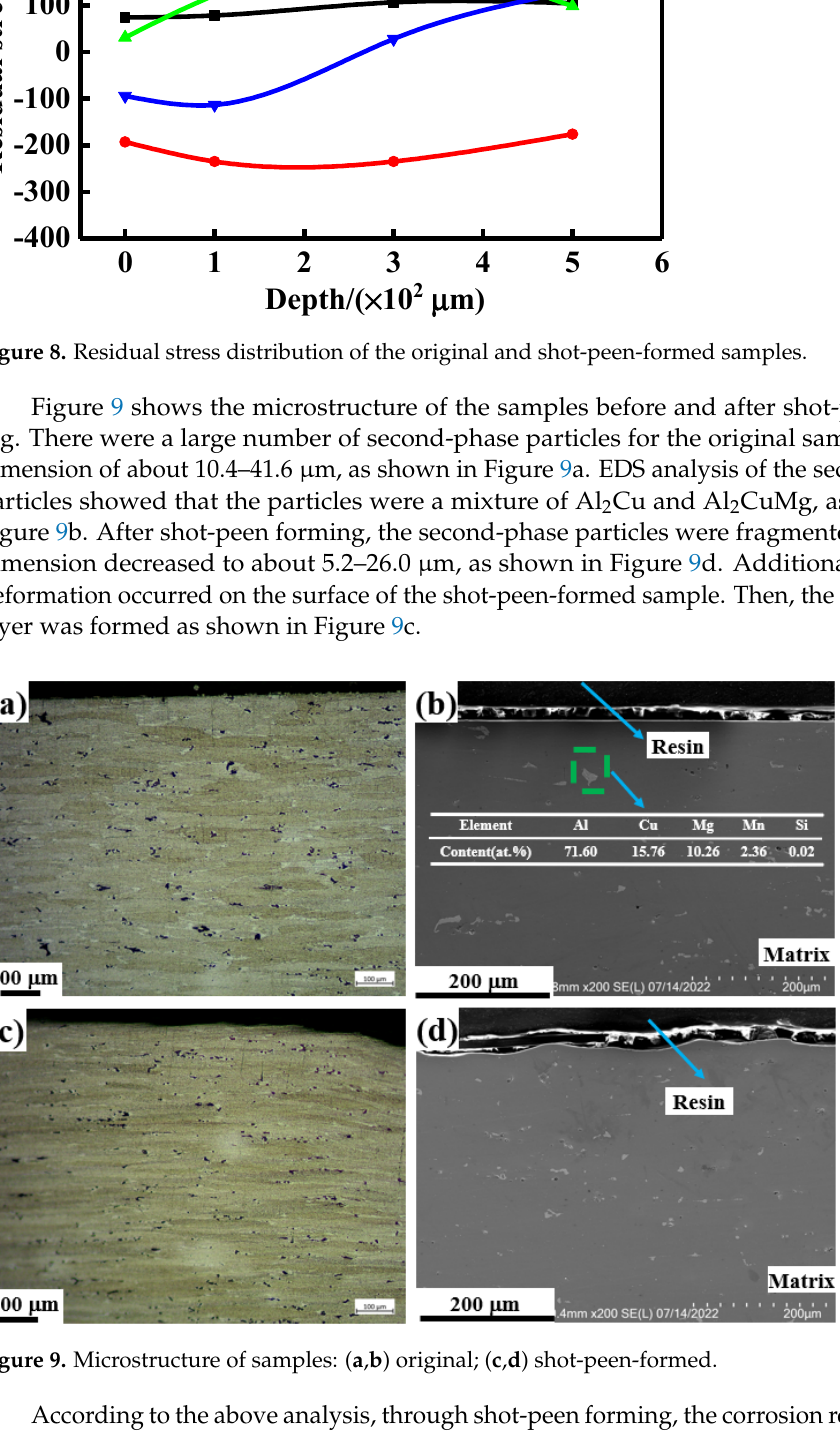
Figure 9. Microstructure of samples: ( a , b ) original; ( c , d ) shot-peen-formed.